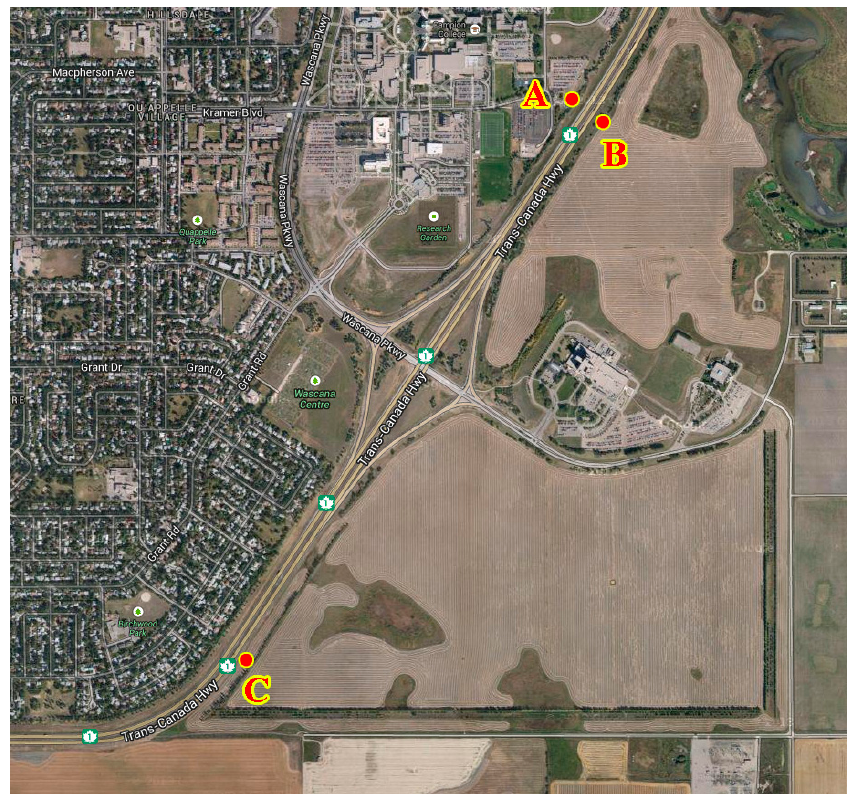
Figure 2. Selection of the measuring sites.